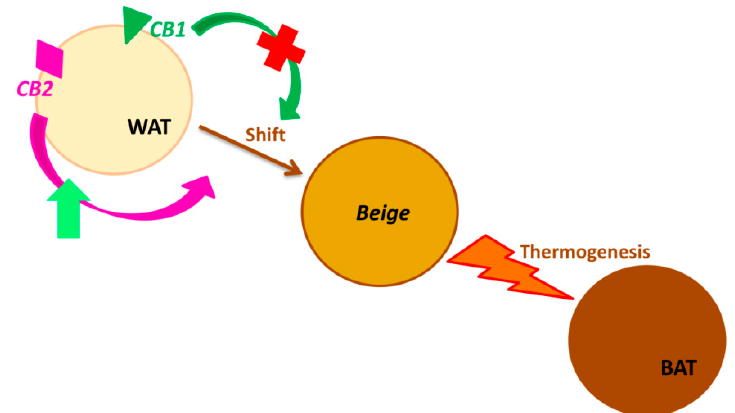
Figure 2. Cannabinoid receptors (CB1 and CB2) in Browning. (Browning is the process by which the white adipose tissue’s physiology and morphology switch from white (WAT) towards brown phenotype (BAT), through the intermediate beige phenotype. CB2 receptor stimulation enhances this transformation, triggering the thermogenesis. Analogously, the blockade of CB1 receptor induces the same adipocyte’s phenotype